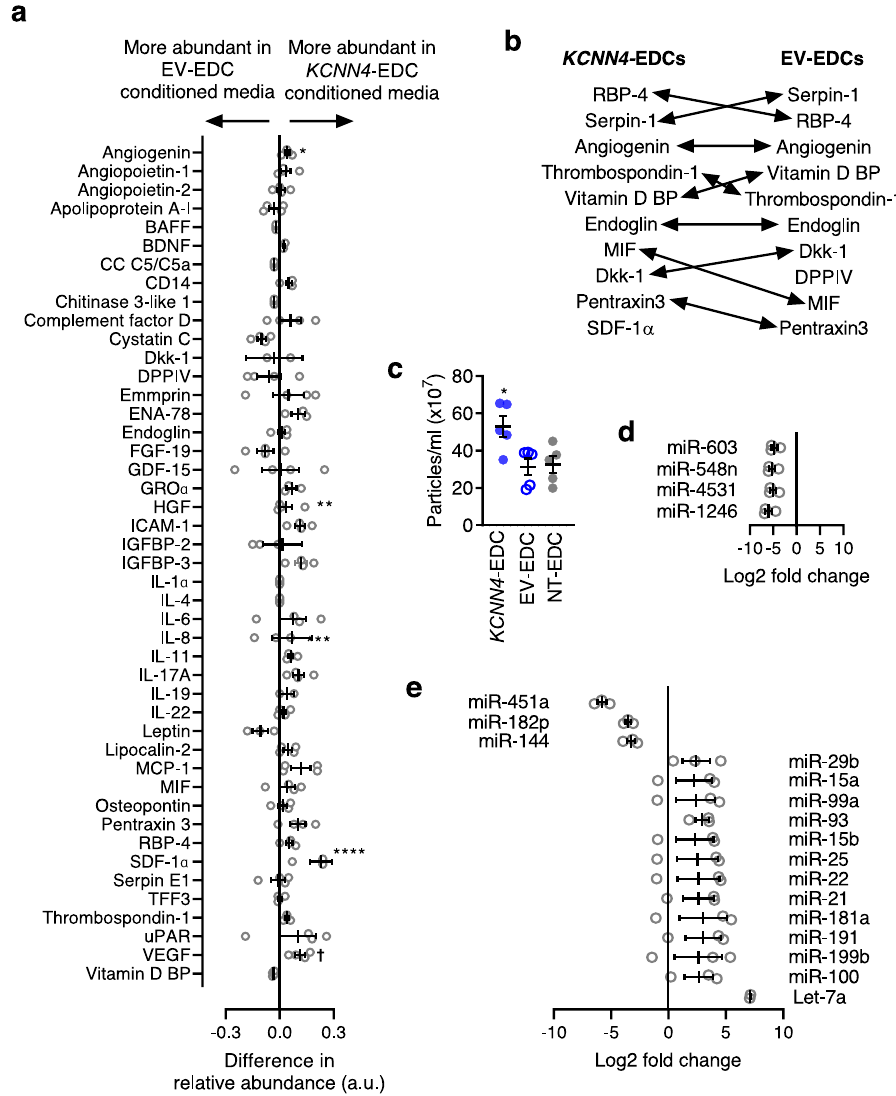
Fig. 7 Effects of KCNN4 overexpression on the paracrine pro fi le of EDCs. a Direct comparison of cytokine proteomic expression within 39 cytokines found to be elevated within media conditioned by EV- or KCNN4 -EDCs. * P < 0.05 vs. EV- or KCNN4 -EDCs, Fisher ’ s exact test. BAFF B-cell activating factor, BDNF brain-derived neurotrophic factor, CC C5/C5a complement Component C5a, Dkk-1 Dickkopf-related protein 1, DPPIV Dipeptidyl peptidase-4, ENA- 78 epithelial-neutrophil activating peptide, FGF- ‘ 9 fi broblast growth factor 19, GDF-15 growth/differentiation factor 15, GRO α growth-regulated oncogene alpha, HGF hepatocyte growth factor, ICAM-1 intercellular adhesion molecule 1, IGBP-2 insulin-like growth factor-binding protein, IGBP-3 insulin-like growth factor-binding protein, IL-6 interleukin-6, IL-8 Interleukin-8, IL-11 interleukin-11, IL-17A interleukin-17A, IL-19 interleukin-19, IL-22 interleukin-22, MCP-1 monocyte chemoattractant protein 1, MIF macrophage migration inhibitory factor, RBP-4 retinol binding protein 4, TFF3 Trefoil factor 3, uPAR urokinase-type plasminogen activator receptor, VEGF vascular endothelial growth factor, Vitamin D BP Vitamin D binding protein. ( n = 4 biological replicates). Data are shown as mean and SEM. b Relative abundance of the top 10 cytokines produced by KCNN4 and EV-EDCs. c Comparison of the size distribution of extracellular vesicles within EDC conditioned media ( n = 5 biological replicates). Effects of KCNN4 overexpression relative to the miRNA expression pro fi le of NT-EDCs ( d n = 3 biological replicates) or EV-EDCs ( e n = 3 biological replicates). Data in c – e are shown as individual points, along with mean and SEM. Signi fi cance is indicated in all panels using * P < 0.05 vs . EV- or KCNN4 -EDCs. For precise P values, see Supplemental Source Data and Statistics fi le. All data were analyzed using a one-way ANOVA with individual-mean comparisons by Bonferroni adjusted two-sided t -test. Blue = KCNN4 - transduced EDCs, gray = EV-EDCs, black = NT-EDCs. EDC explant-derived cell, EV empty vector, min minutes, V mem membrane